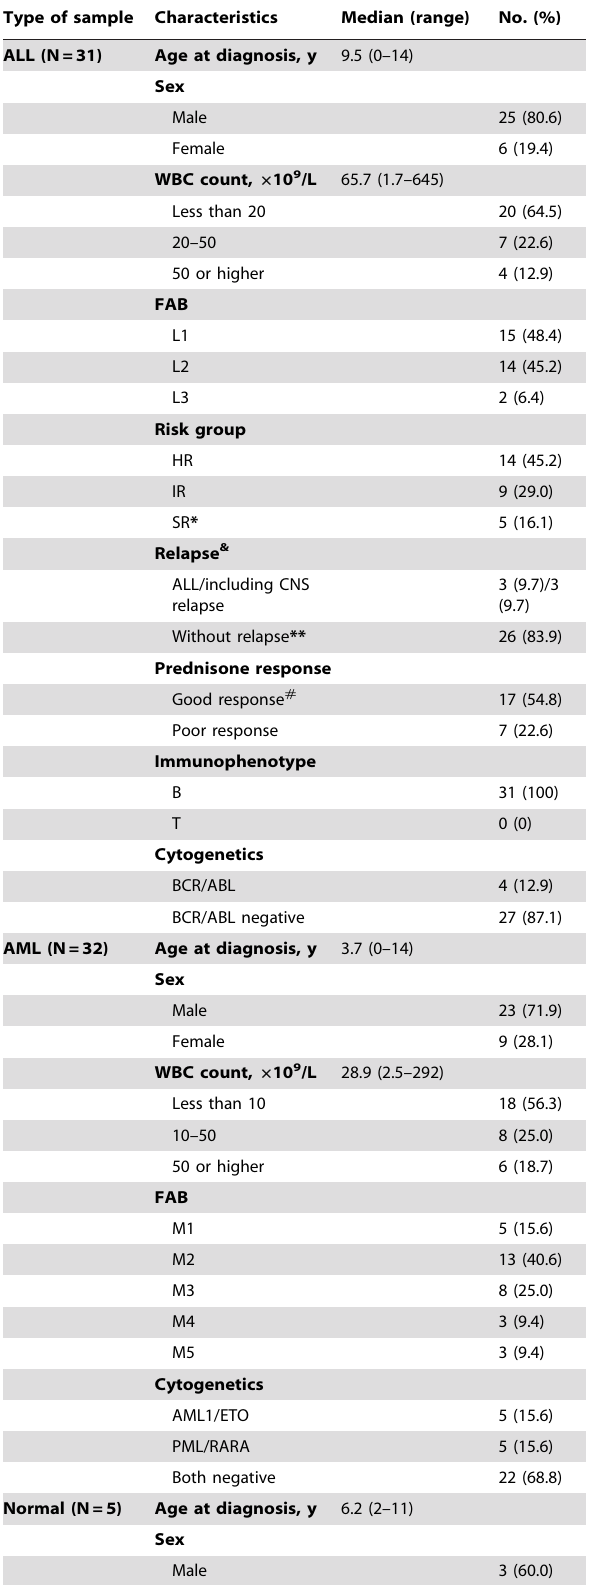
Table 2. Characteristics of validation